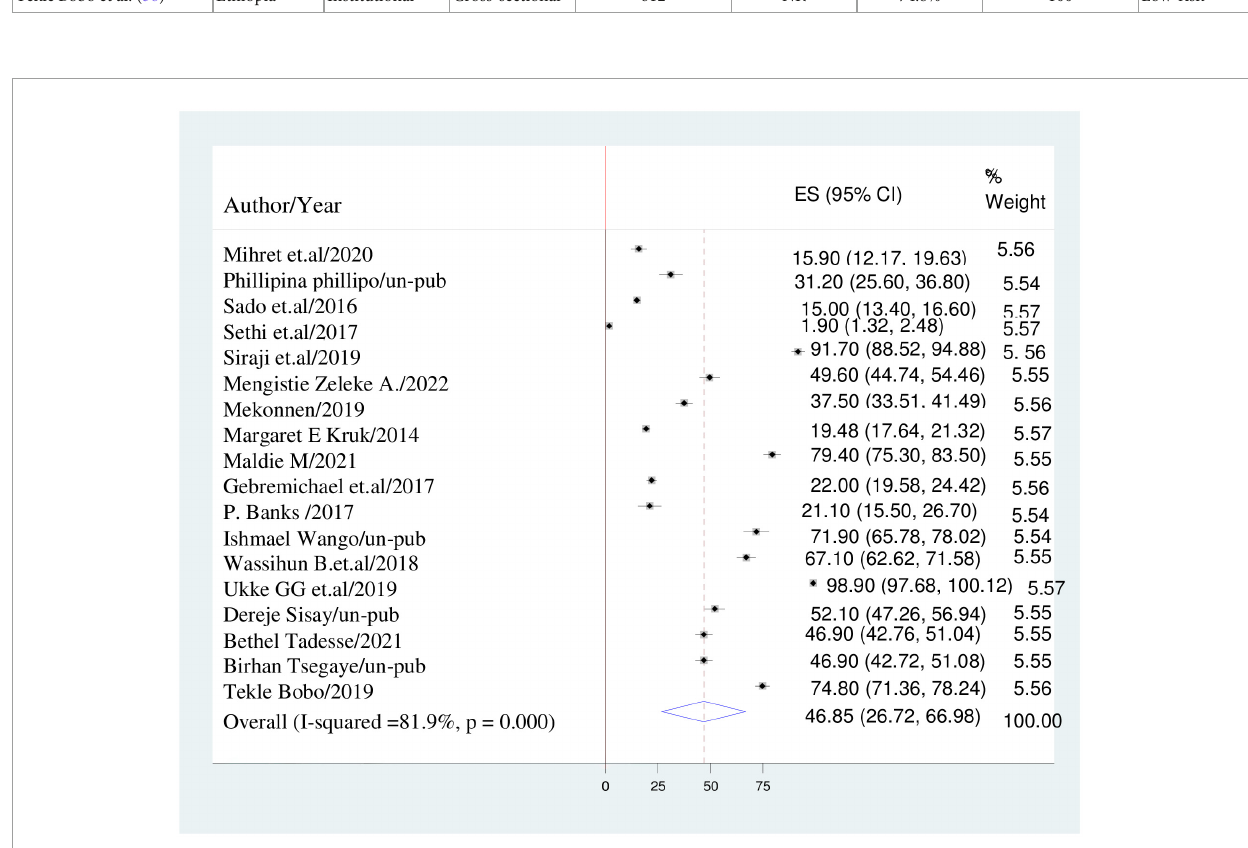
FIGURE2 Forest plot displaying the pooled prevalence of disrespect and abuse of women during childbirth in